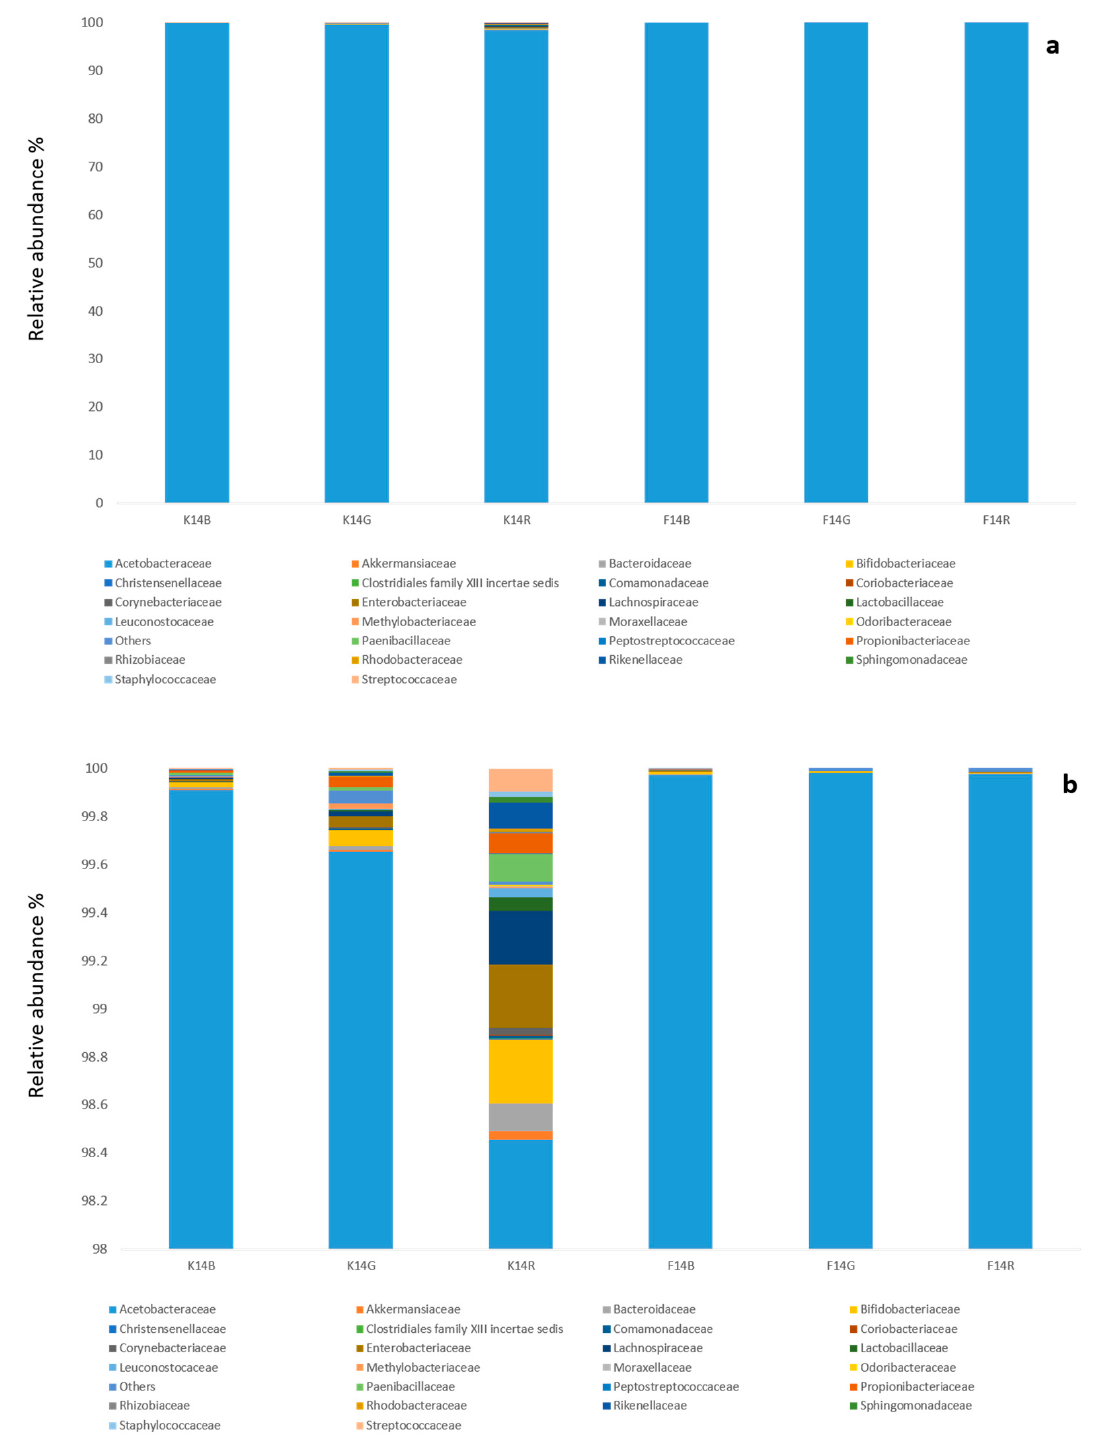
Figure 1. The influence of substrate and matrix on bacterial community structure of kombucha (family level), after 14 days of fermentation, as determined by 16S rRNA gene amplicon sequencing, showing in ( a ) the relative abundance from 0 to 100% and ( b ) the focus in the range between 98 and 100%.